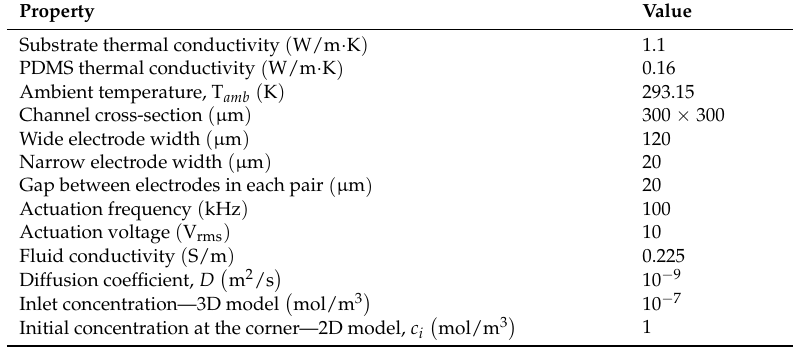
Table 1. Design parameters and fluid properties used in the numerical simulation.